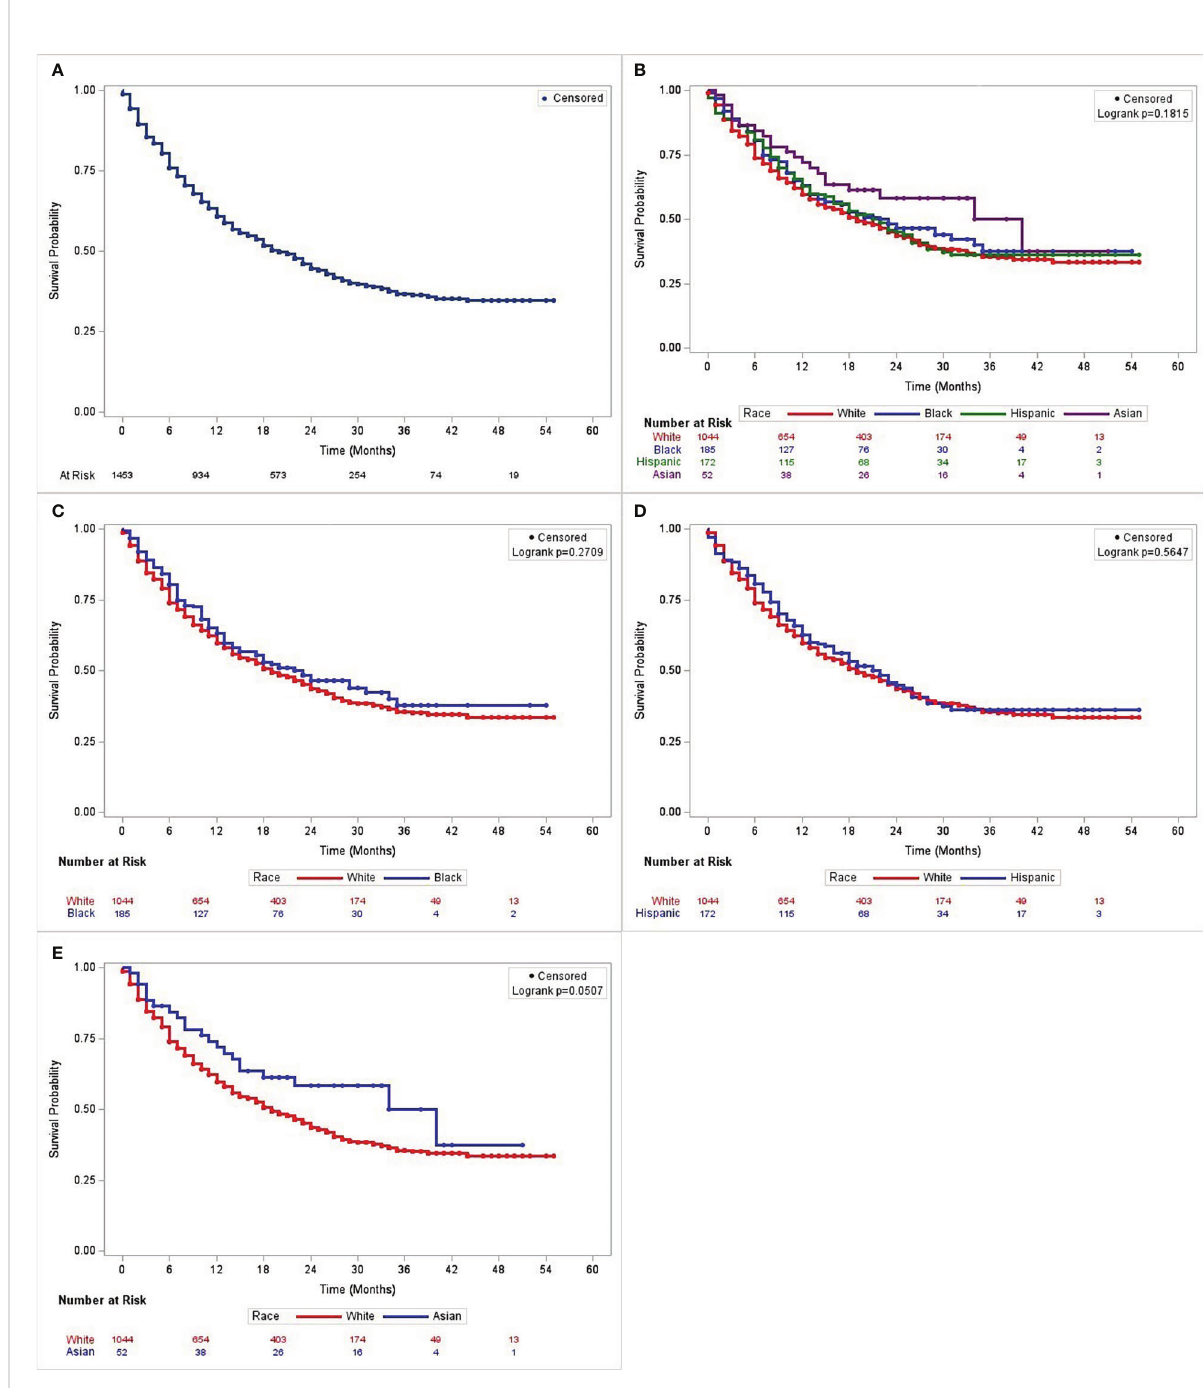
FIGURE 2 Kaplan-Meier curves showing disease-speci fi c survival in patients with non-small cell lung cancer who received immunotherapy as the fi rst course of treatment in Texas from 2009 to 2018. From L to R: (A) the entire cohort; (B) patients strati fi ed by race and ethnicity; and comparisons between (C) African American and White patients, (D) Hispanic and White patients, and (E) Asian and White